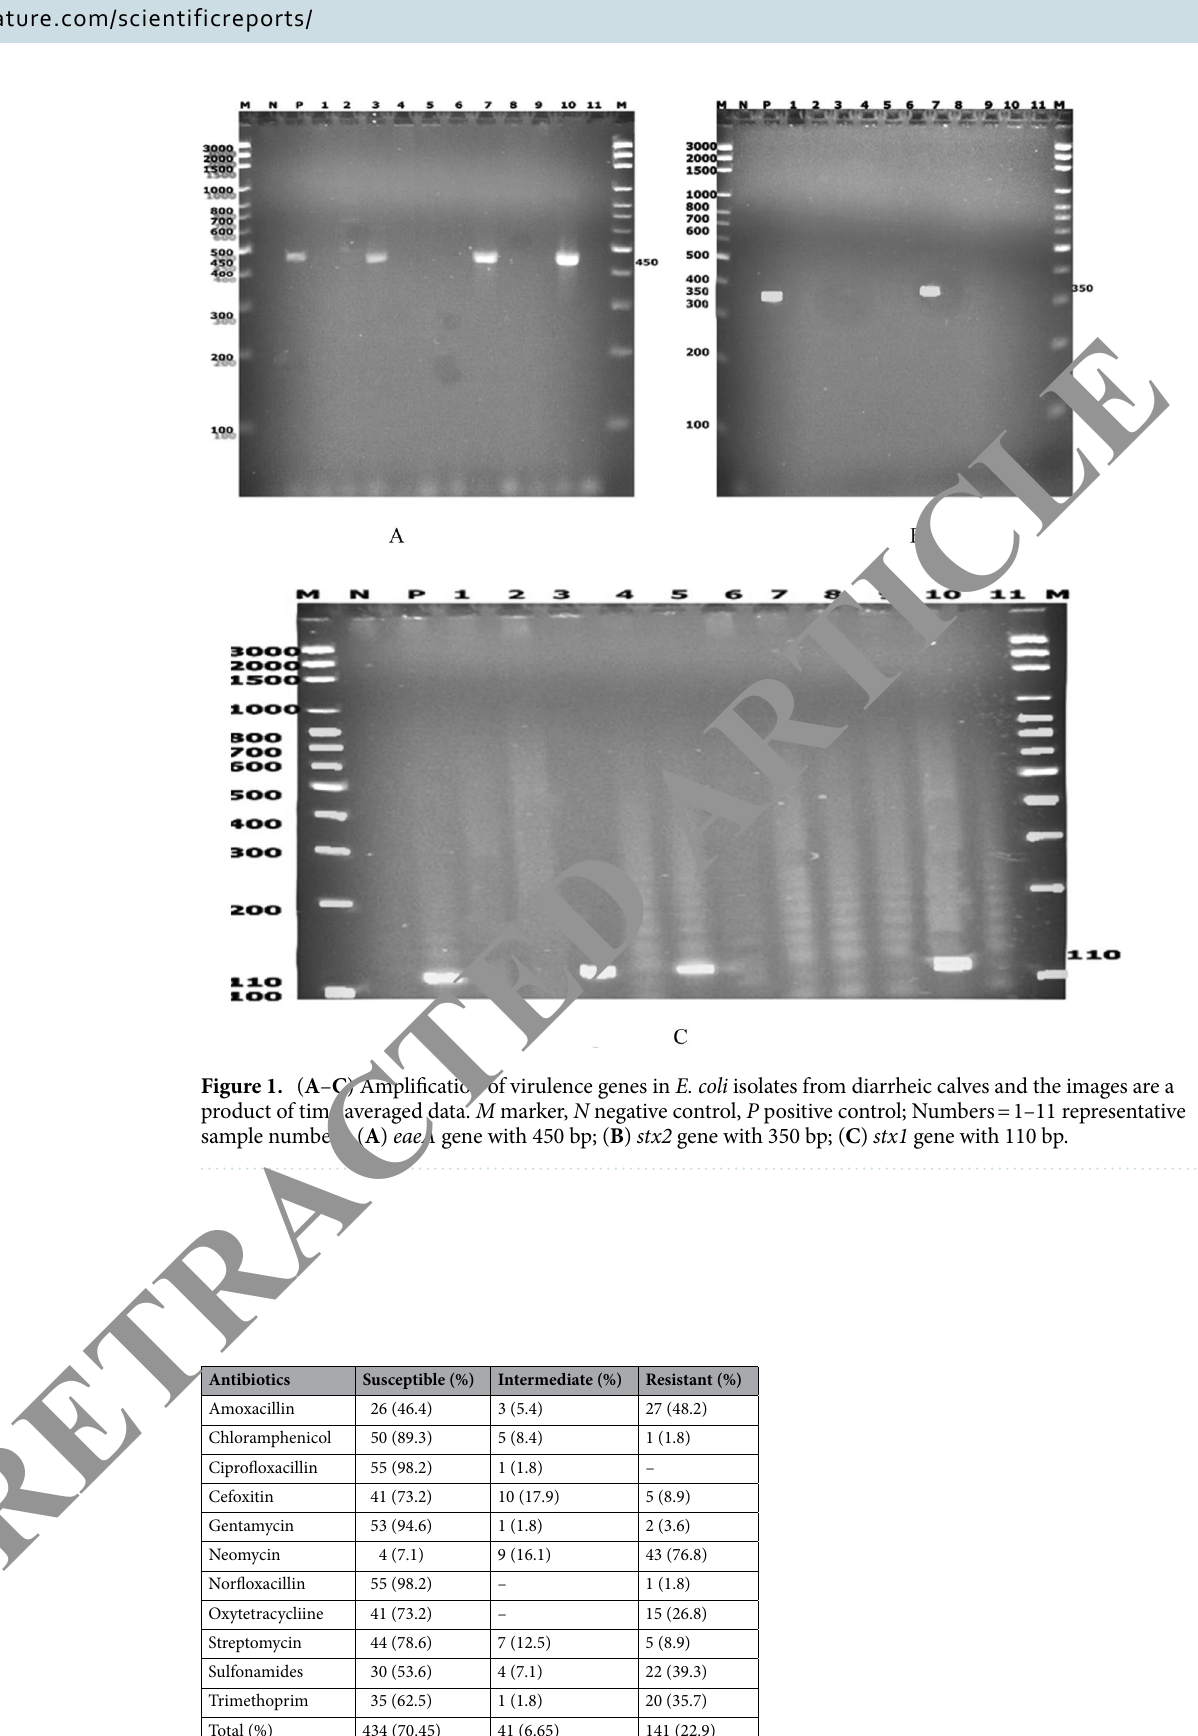
Table 4. Number (%) of E. coli isolates (56) resistant to